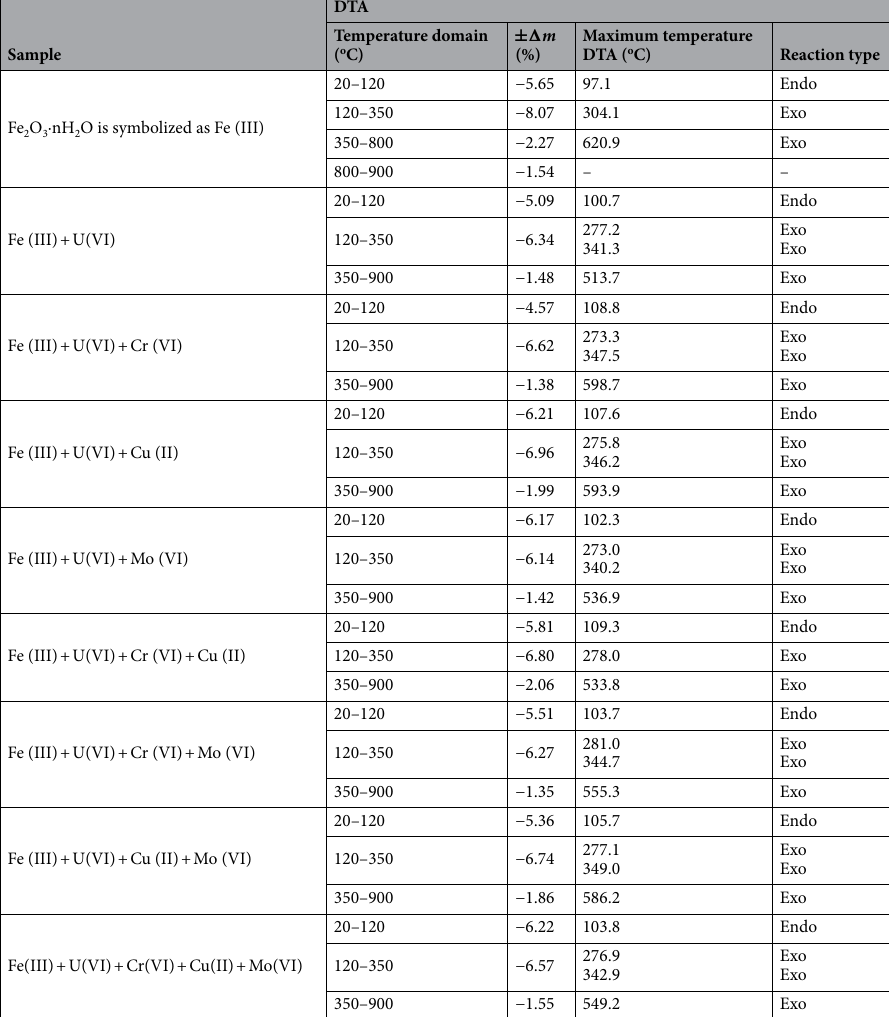
Table 4. They were processed according to the proposed flowsheet (Fig. 12) with and without pH adjustment respectively. The pH was adjusted with 0.1 M HCl solution to the working value of 8.75. It was observed that the U(VI) removal efficiency was higher after pH adjustment, so that the sorption flota- tion was very efficient (Fig. 11). Figure 12 summarizes a proposed technological processing diagram (flowsheet) of the multi-contaminated aqueous system by sorption flotation. In case the samples were processed without pH adjustment the separation efficiencies were 96.6% for sample MW1 and 97.2 for MW2 and MW3 samples, respectively (Fig. 13). In case the samples were processed with pH adjustment at pH = 8.75 with 0.1 M HCl solution %R U(VI) > 99 was obtained for MW1C–MW3C samples (Fig. 13). One can note that U(VI) removal efficiency was higher for the pH-adjusted samples than for the others, confirming the optimal values of the previously studied parameters. The generated solid waste may be stored or recycled as a U(VI) secondary source for the manufacture of nuclear fuel. The optimal parameters validation of tandem process immobilization on NMS-flotation on real water samples was performed in two variants: a. Without pH adjustment and sorbent addition: The real water samples with the chemical composition shown in Table 4 (300 mL) MW1–MW3 were pre-treated with 0.15 g NMS and were contacted for 30 min under 250 RPM stirring. The solid phase was separated by decantation. To the resulting liquid phase, MW1i– MW3i, the appropriate amount of 0.25 × 10 −3 M NaOL solution was added and flotated without pH adjust-